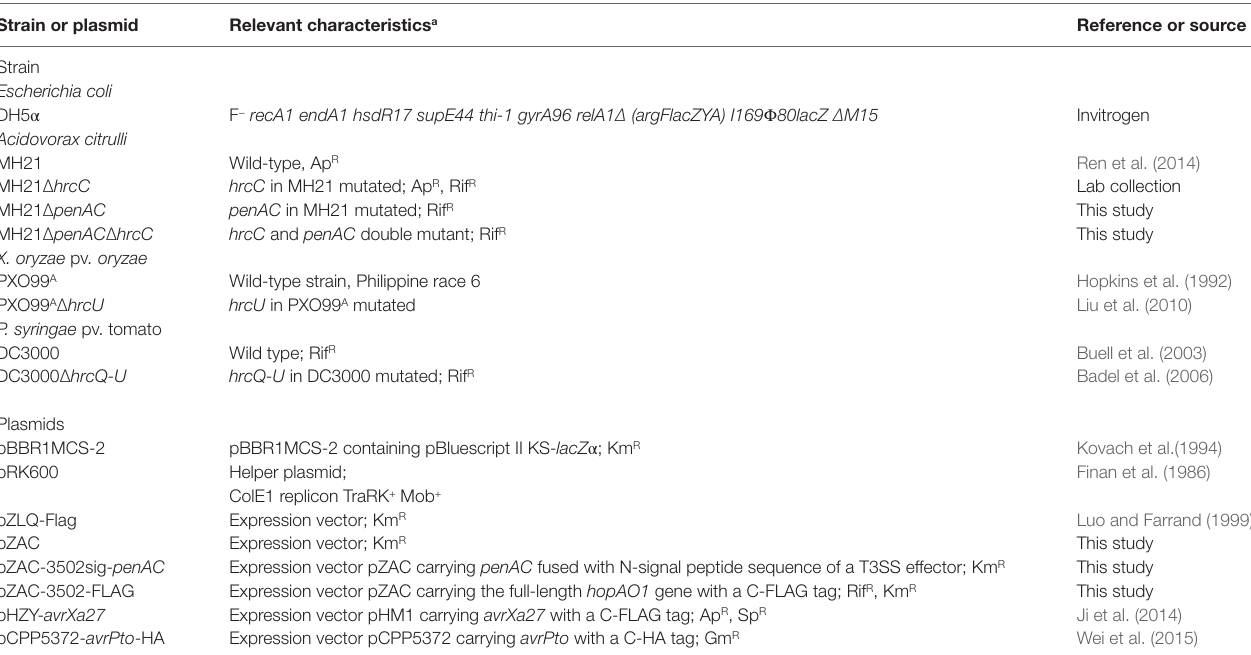
TABLE 1 | Bacterial strains and plasmids used in this